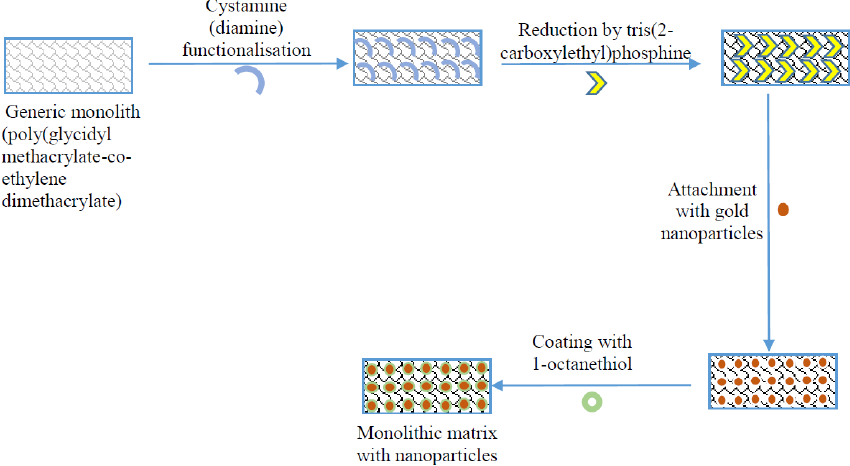
Figure 1. Schematic of the enhancement of monolithic surface with suitable activation chemistries and gold nanoparticles (adapted from [20]).